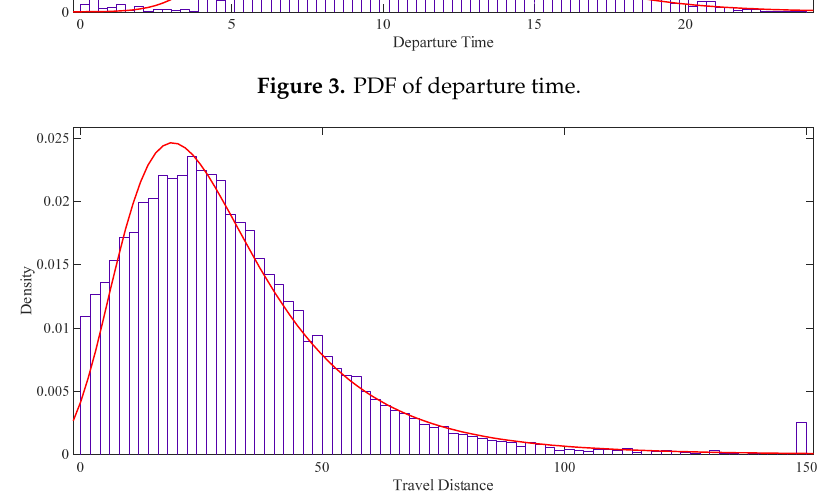
Figure 4. PDF of travel distance.